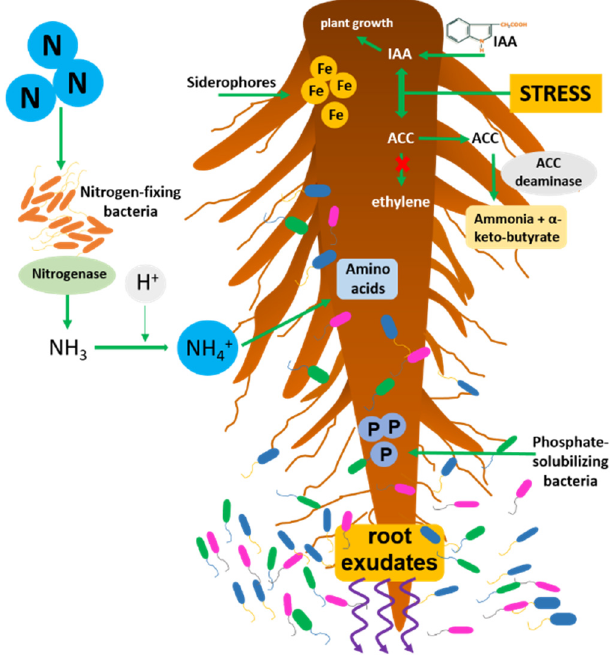
Figure 2. Simplified scheme of the main activities of PGPR and their interactions with the root system; nitrogen-fixation, phosphate solubilization, iron uptake by siderophores, ACC deaminase activity lowering ethylene levels, IAA production stimulating plant cell growth.